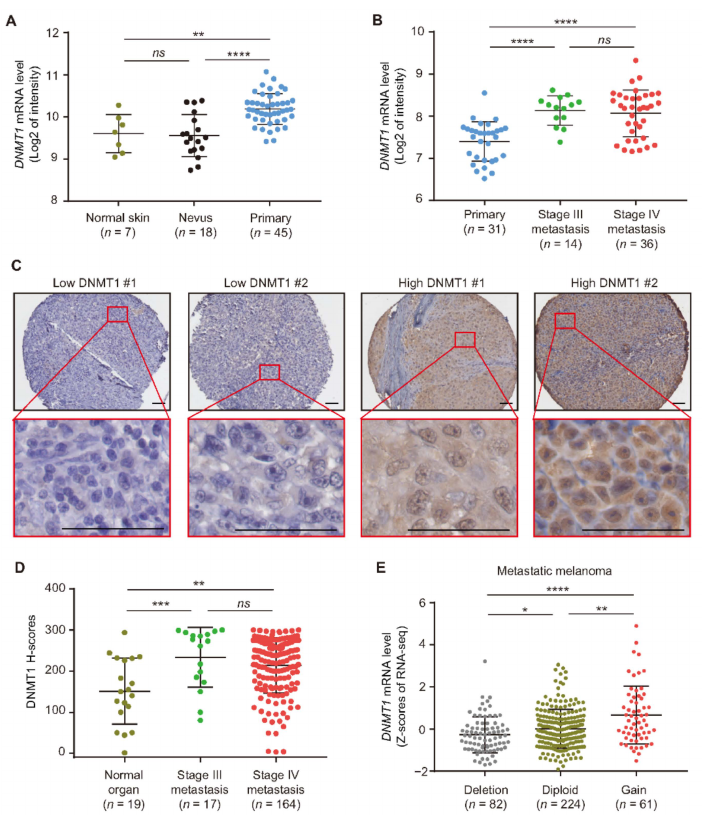
Figure 1. DNMT1 expression is enhanced in metastatic melanoma. ( A ) Comparison of DNMT1 mRNA expression in normal skin, nevus, and primary melanoma samples using GSE3189 microarray dataset. ( B ) Comparison of DNMT1 mRNA expression in primary melanoma, stage III, and stage IV metastatic melanoma tissues using the GSE8401 microarray dataset. ( C , D ) Representative IHC images and H-score quantification of DNMT1 in normal organ tissues, stage III, and stage IV metastatic melanoma tissues from the TMA cohort. Scale bars = 20 µ m. ( E ) Distribution of DNMT1 mRNA levels in metastatic melanoma patients with hemizygous deletion, diploid, and gain using the TCGA metastatic melanoma dataset ( n = 367). Data represent the mean ± SD. ns : not significant, * p < 0.05, ** p < 0.01, *** p < 0.001, and **** p <